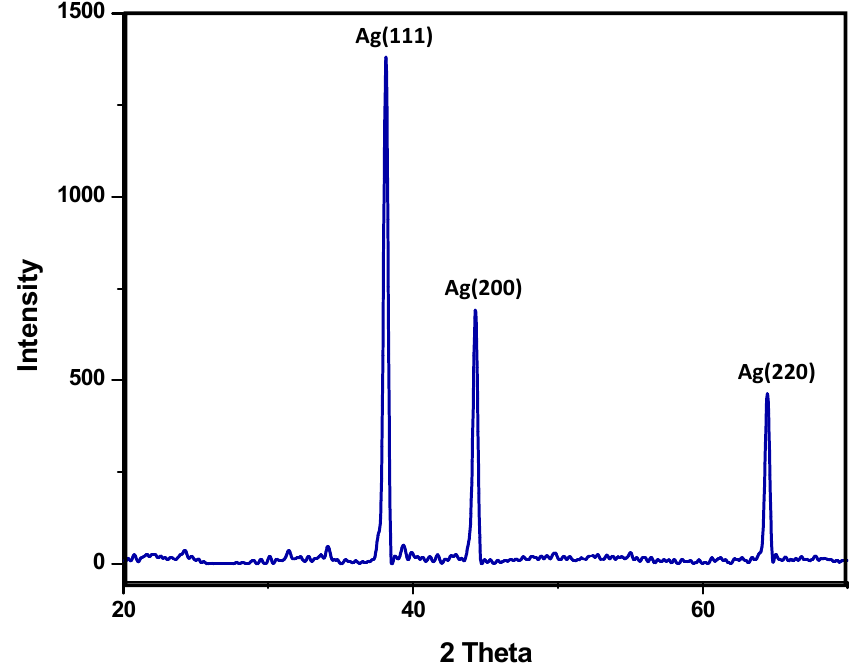
Figure 9. X-ray di ff raction analysis of silver conductive Figure 9. X-ray diffraction analysis of silver conductive film.